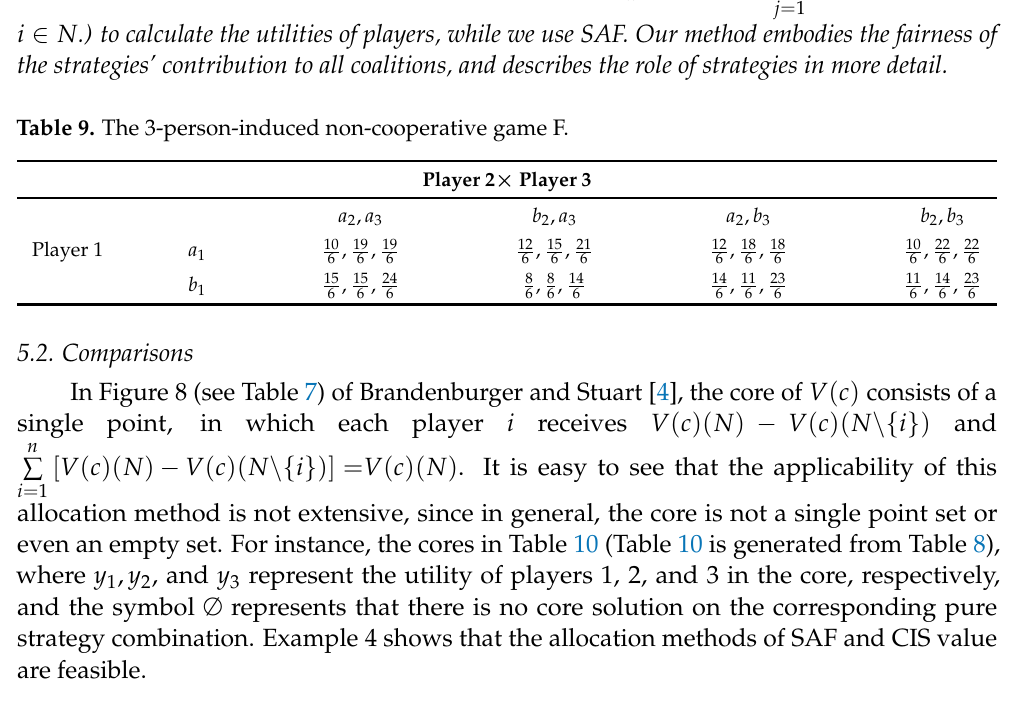
Table 10. The cores of the 3-person biform game